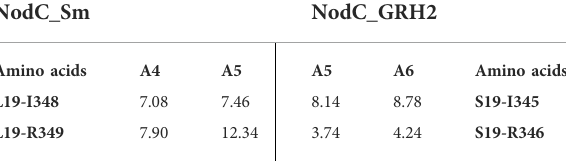
TABLE 2 Distances measured during MD simulations. Shown are the average distances from one simulation between certain